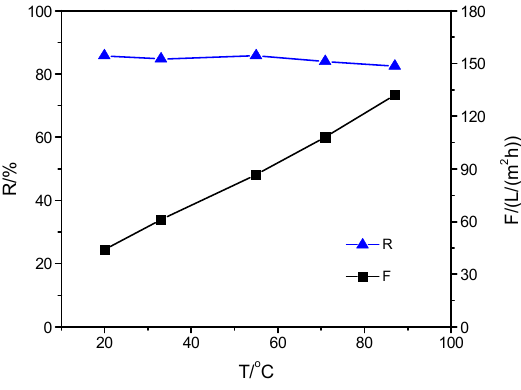
Figure 3. Influence of operating temperature on the properties of SPPBES composite membrane.